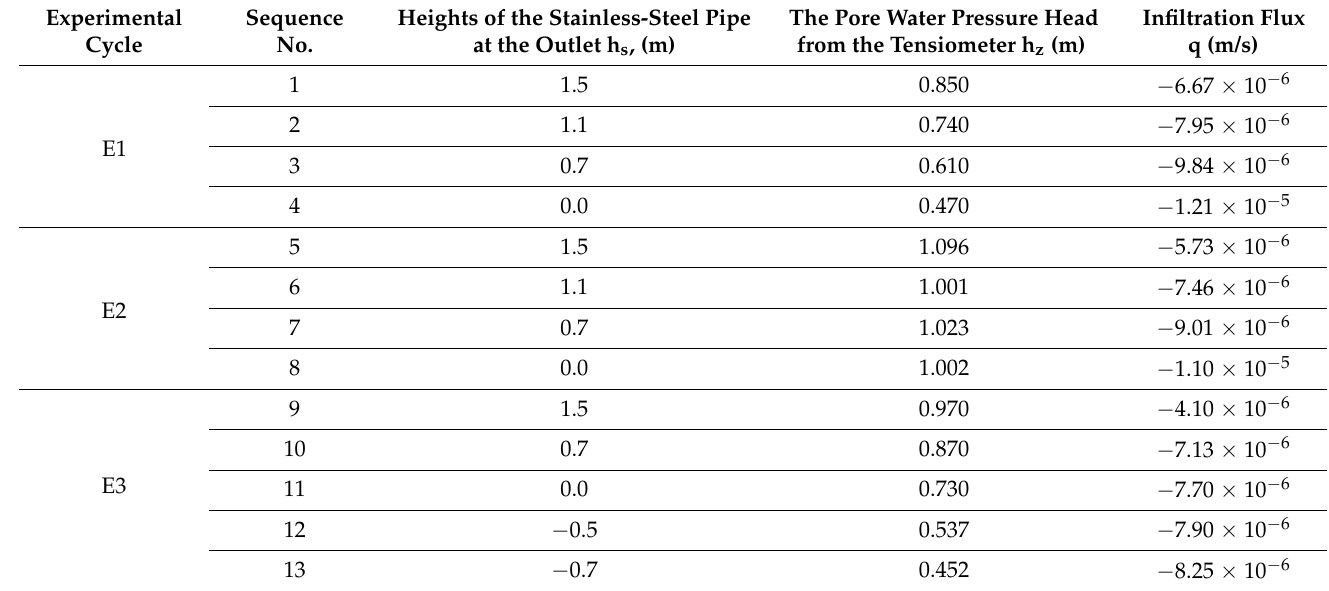
Table 1. The bottom boundary conditions and experimental results in each infiltration experiment. The sequence number implied the sequence of the use of the pipe height in experimental cycles.